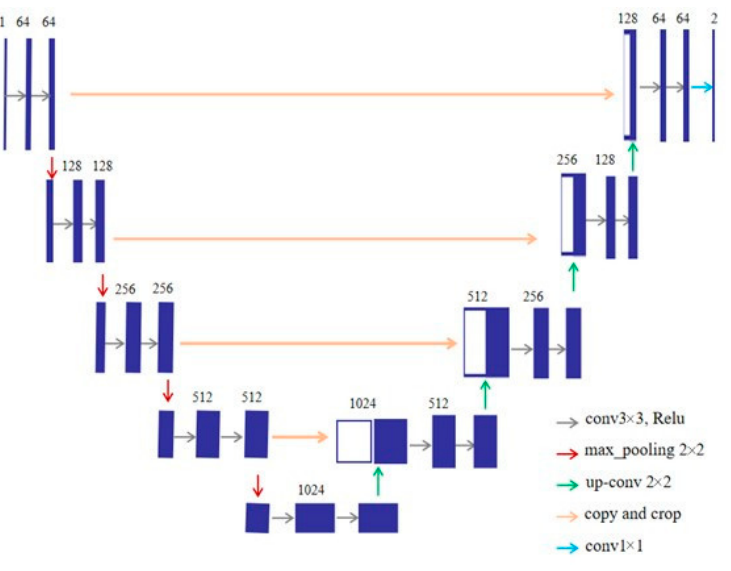
Figure 7. Framework of U-Net.